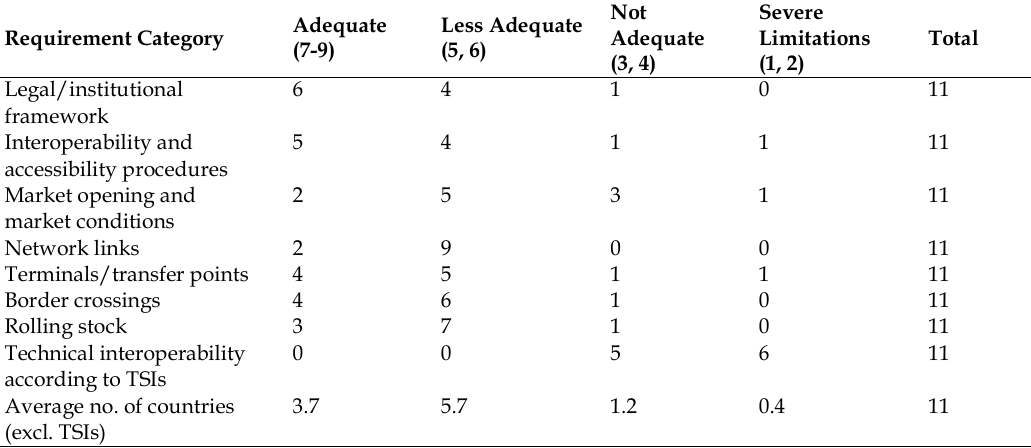
Table 5. Summary of scores on